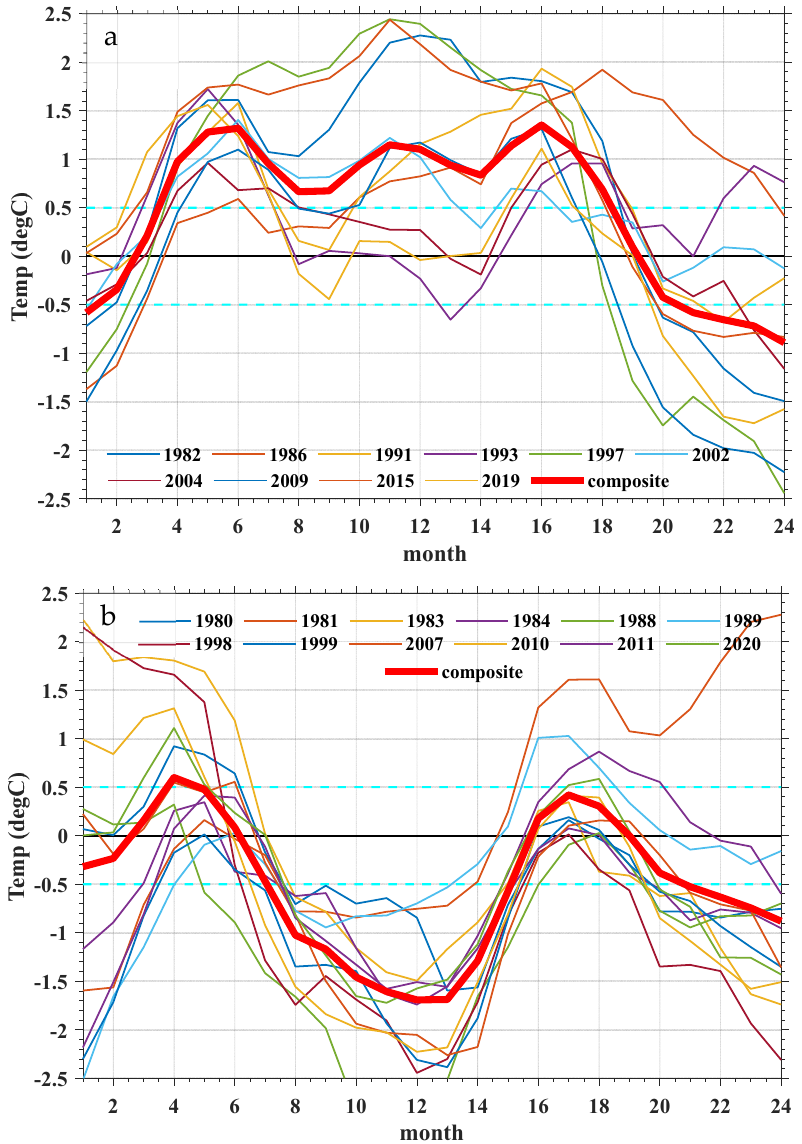
Figure 7. The SSTAs in the 5°S − 5°N, 190°E − 240°E region from the selected ENSO events. ( a ) El Niño, ( b ) La Niña. Thin lines represent the ENSO events, and thick lines represent the composite SSTA obtained by averaging the SSTAs. Table 1. Simulation experiment design.